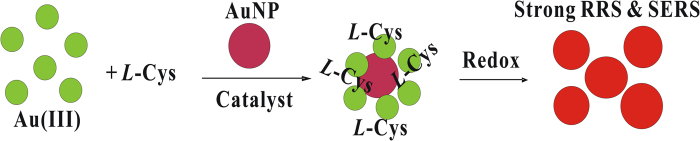
Schematic diagram of generating AuNPS.